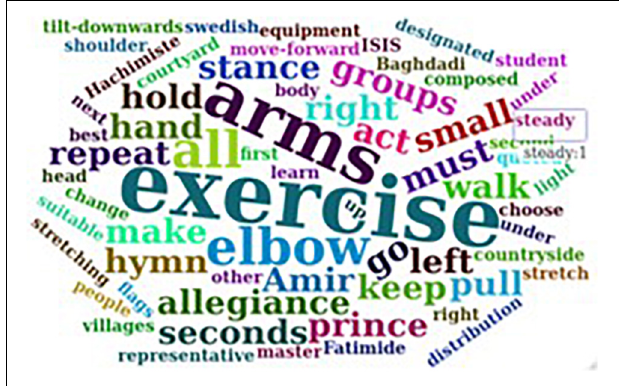
FIGURE 6 | Lesson #7 - words